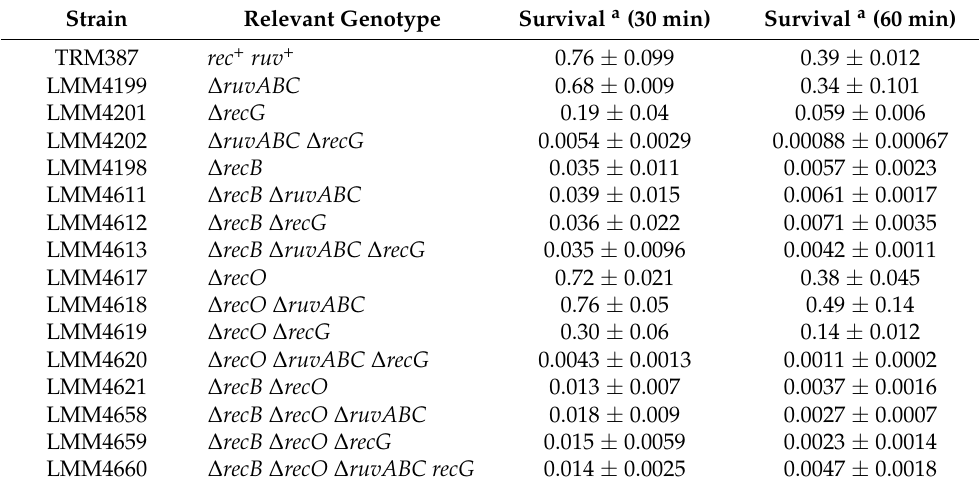
Table 1. Survival of different E. coli mutants after I- Sce I endonuclease expression. Statistical analysis is provided in Tables S2 and S3. Strain Relevant Genotype Survival a (30 min) Survival a (60 min) TRM387 rec + ruv + 0.76 ±